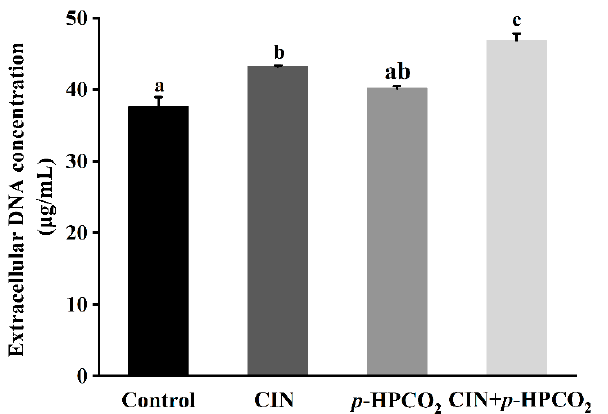
Figure 4. Extracellular DNA content of Saccharomyces cerevisiae after individual and combined treatments with cinnamon oil (CIN) (0.02%) and petit -high pressure CO 2 ( p -HPCO 2 ) (1.3 MPa) for 2 h at 25 °C. Different letters above bars indicate significant differences ( p < 0.05).